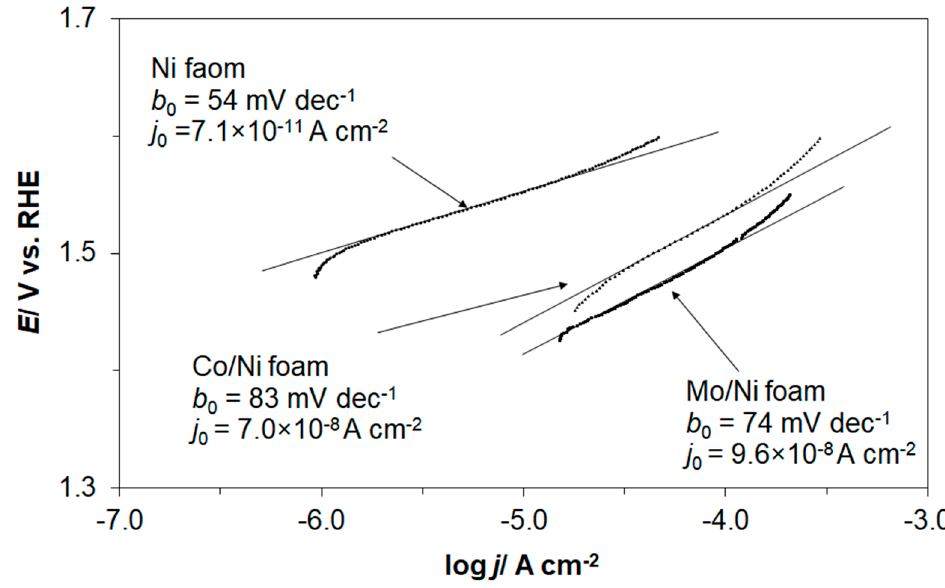
Figure 3. Quasi -potentiostatic anodic Tafel polarization curves (recorded at a scan-rate of 0.5 mV s − 1 ) for oxidized Ni foam, Co- and Mo-activated Ni foam electrodes, carried out in 0.1 M NaOH solution (appropriate iR corrections were made based on the solution resistance derived from impedance measurements); calculated Tafel slopes for oxidized Ni foam, Co- and Mo-modified Ni foam samples came to b a = 54, 83 and 74 mV dec − 1 , correspondingly.